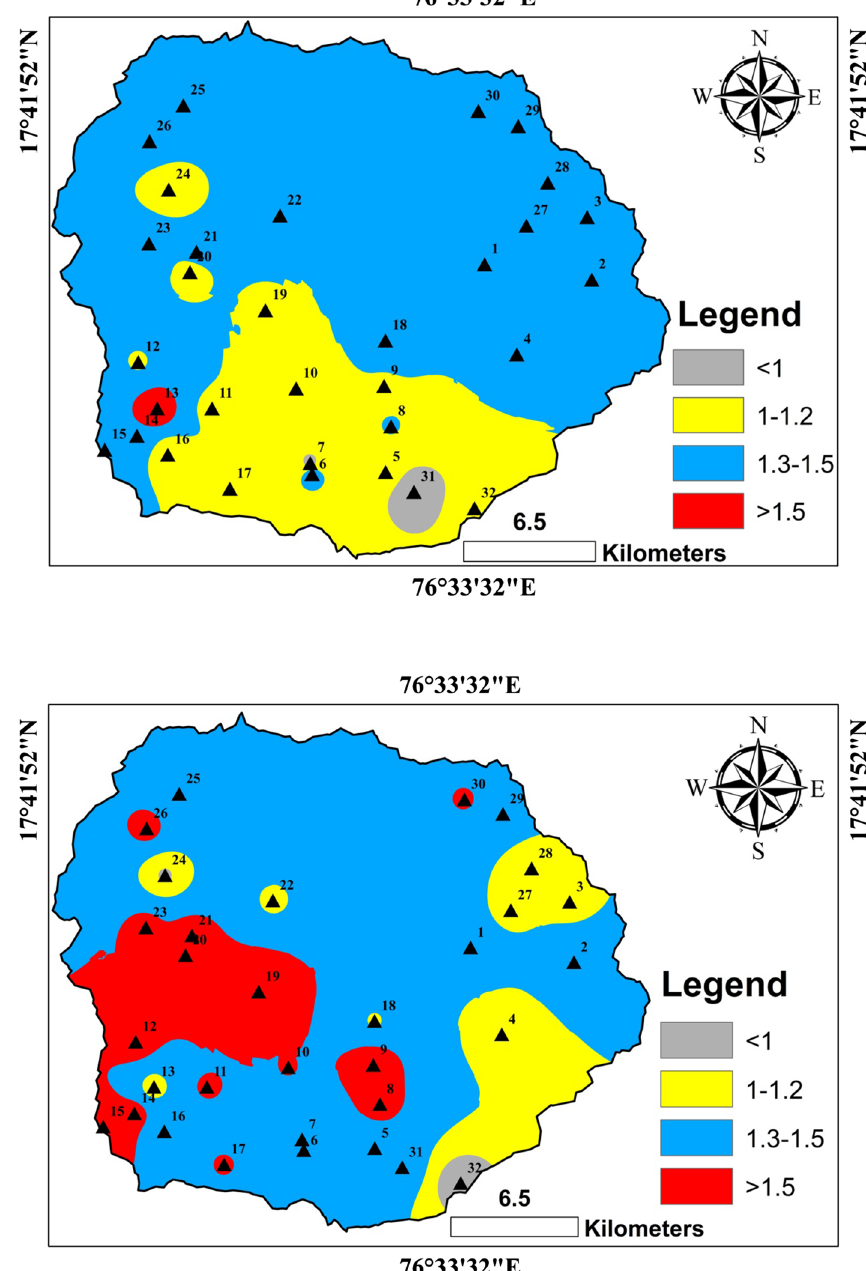
Fig. 24 Geospatial distribution of fluoride (pre-monsoon)